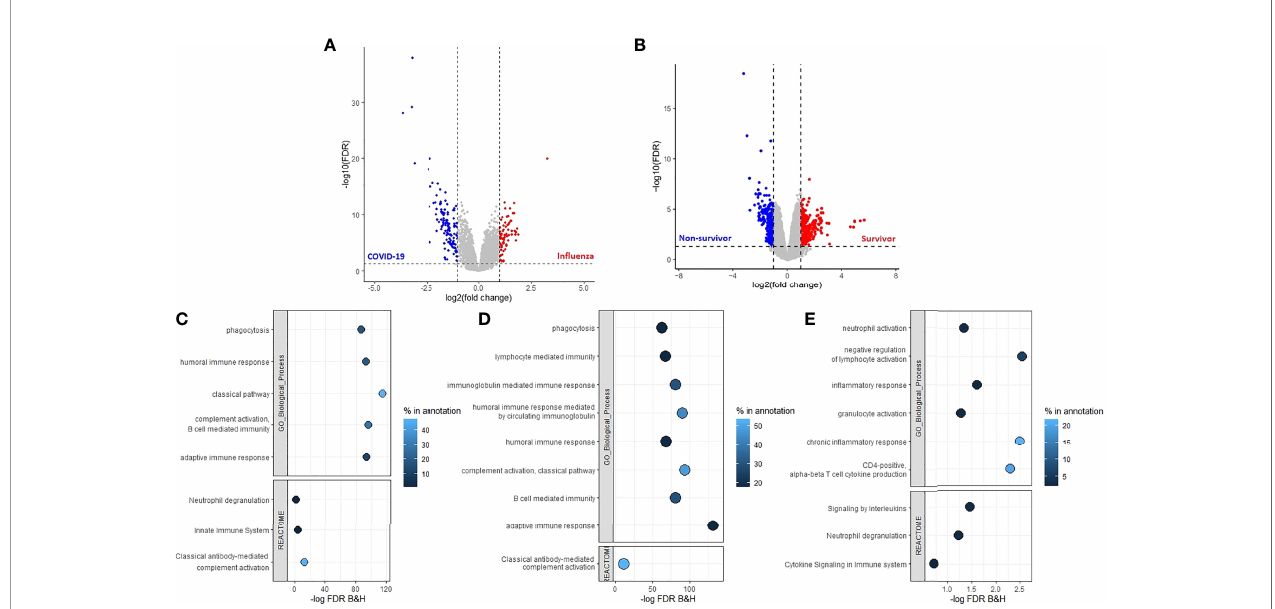
FIGURE 3 | Adaptive immune response associated with COVID-19 and a positive patient outcome. Volcano plots (A) between patients with COVID-19 or in fl uenza and (B) between COVID-19 survivors and non-survivors, threshold criteria used FDR < 0.05 and log2 fold change < -1 or >1, transcript which met criteria were used for enrichment analysis with ToppGene. (C) Enrichment analysis of the transcripts with an increased abundance in patients with COVID-19 identi fi ed an increased adaptive immune response which was also detected in (D) patients with COVID-19 who were still alive 30 days after hospital admission. (E) Increased innate immune response in patients who died of COVID-19 after 30 days of hospital admission. Percentage in annotation is the ratio of the input query genes overlapping with the genes in the pathway